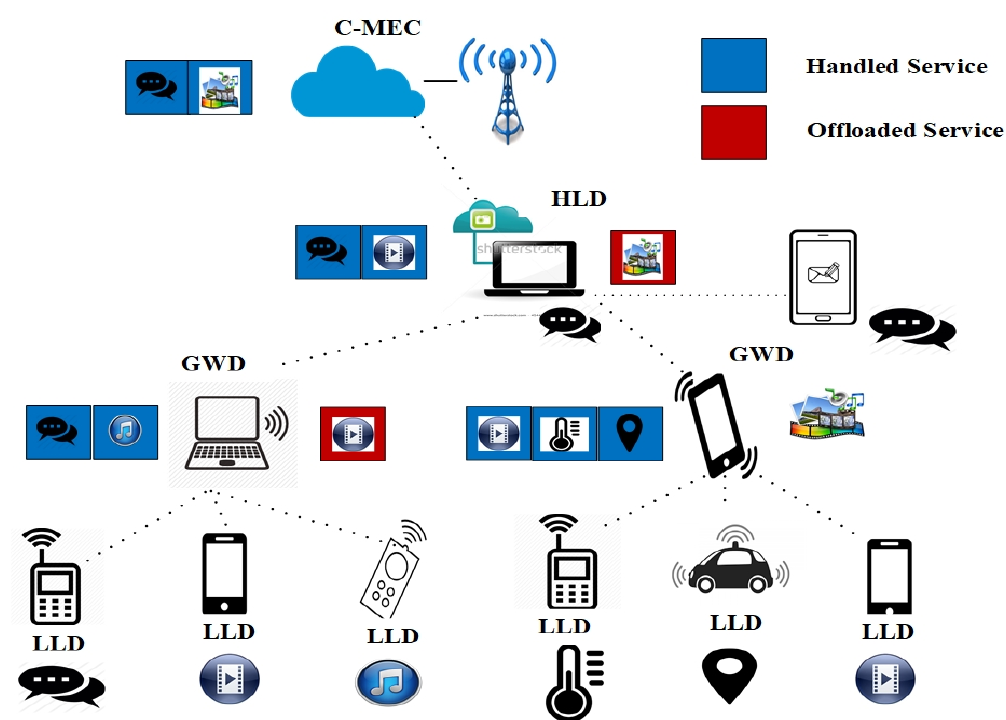
Figure 6. Heterogenous task handling and offloading over a D2D network.